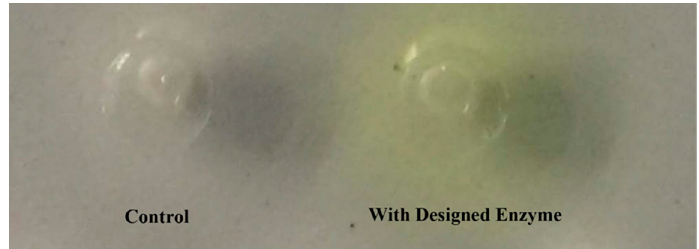
Figure 5. Colorimetric activity assay of the designed esterase. The purified esterase was spotted on an agar plate containing p-NPA. The site containing the enzyme turned yellow, while the site containing a blank solution did not change color.